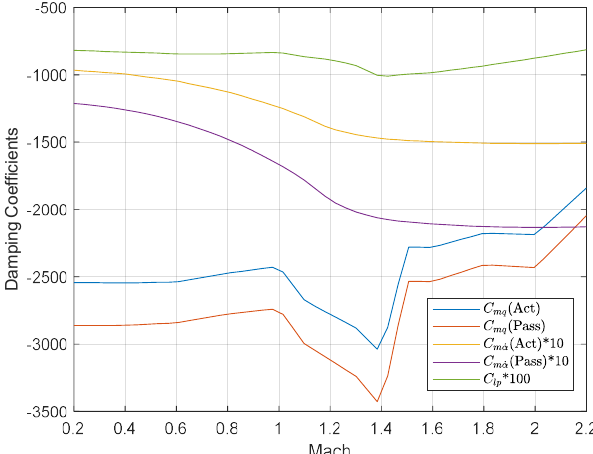
Figure 4. Rocket Motor Thrust-Time Curve at Sea Level.